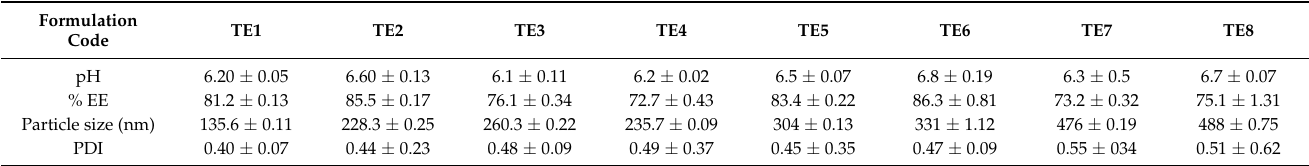
Table 2. Physio-chemical behavior of transethosomes after six months of stability (mean ± SD, n = 5). Formulation Code